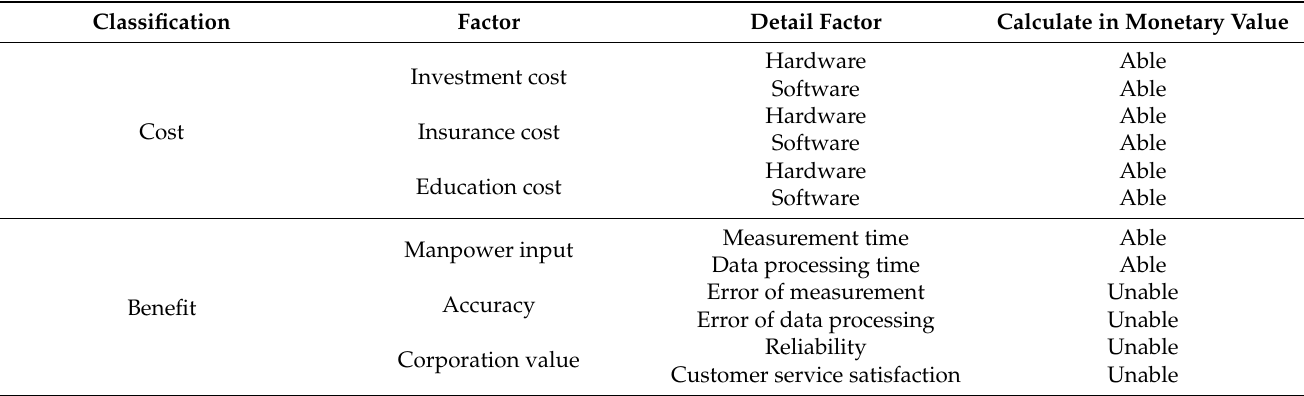
Table 3. Cost and benefits factors of